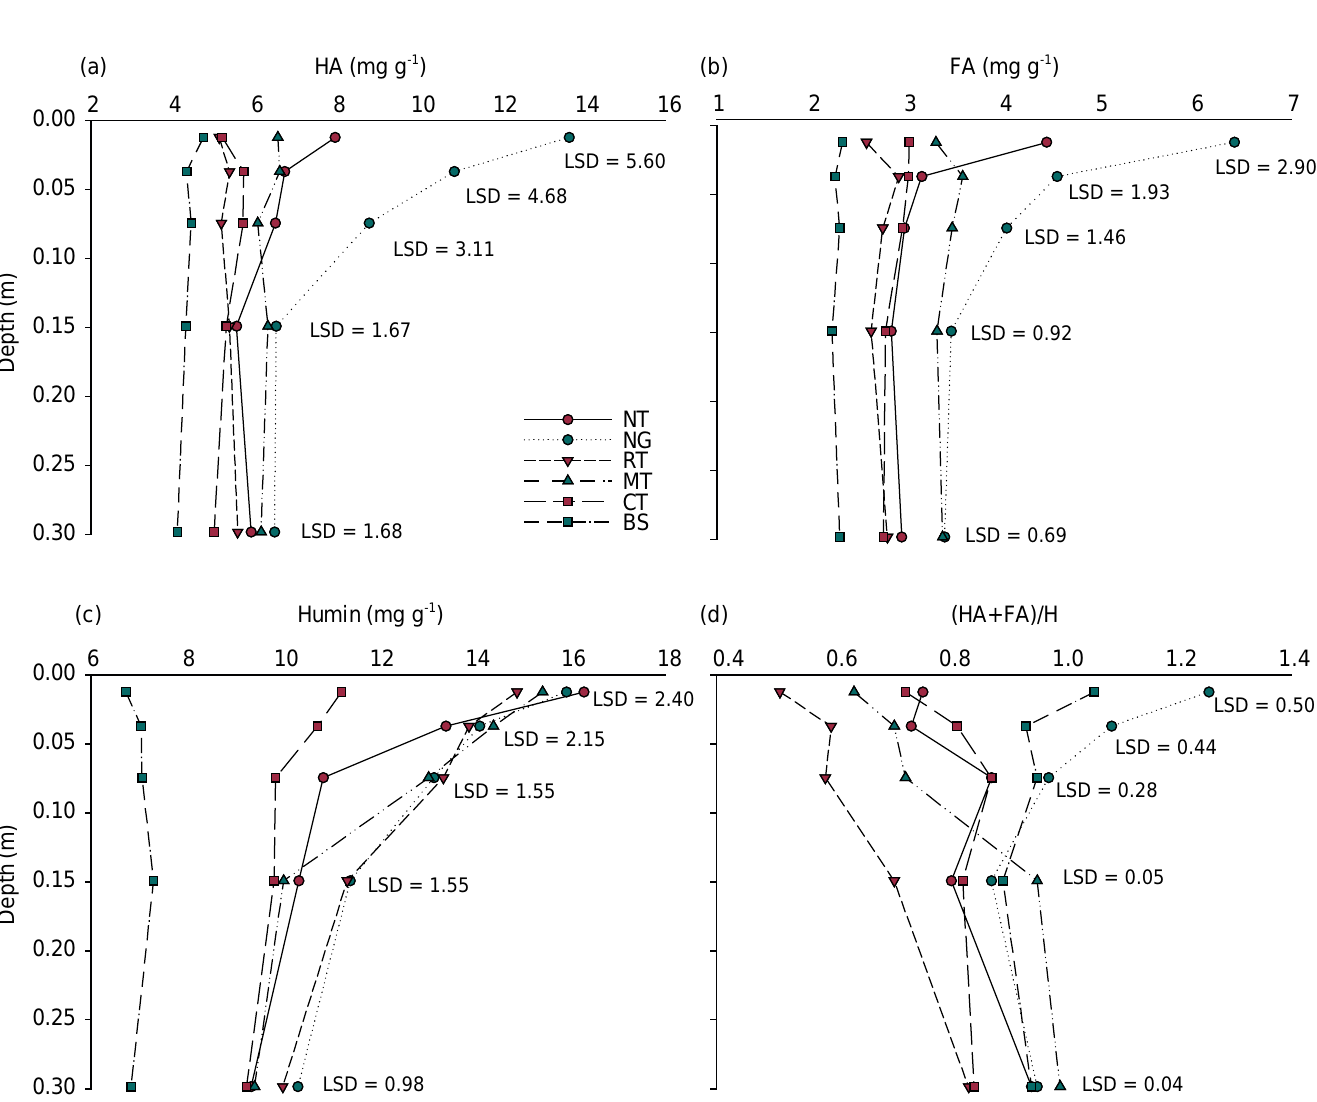
Figure 2. Contents of humic acid (a), fulvic acid (b), humin (c), and the (HA+FA)/H ratio (d) in an Inceptisol after 27 years under various soil tillage methods: no-tillage (NT), rotating tillage (RT), minimum tillage (MT), conventional tillage (CT), bare soil (BS), and natural grassland (NG) as a reference, in the 0.000-0.025, 0.025-0.050, 0.050-0.100, 0.100-0.200, and 0.200-0.400 m layer. LSD = least significant difference between treatment means in the treatments comparing all depths evaluated; HA = humic acid; FA = fulvic acid; H =